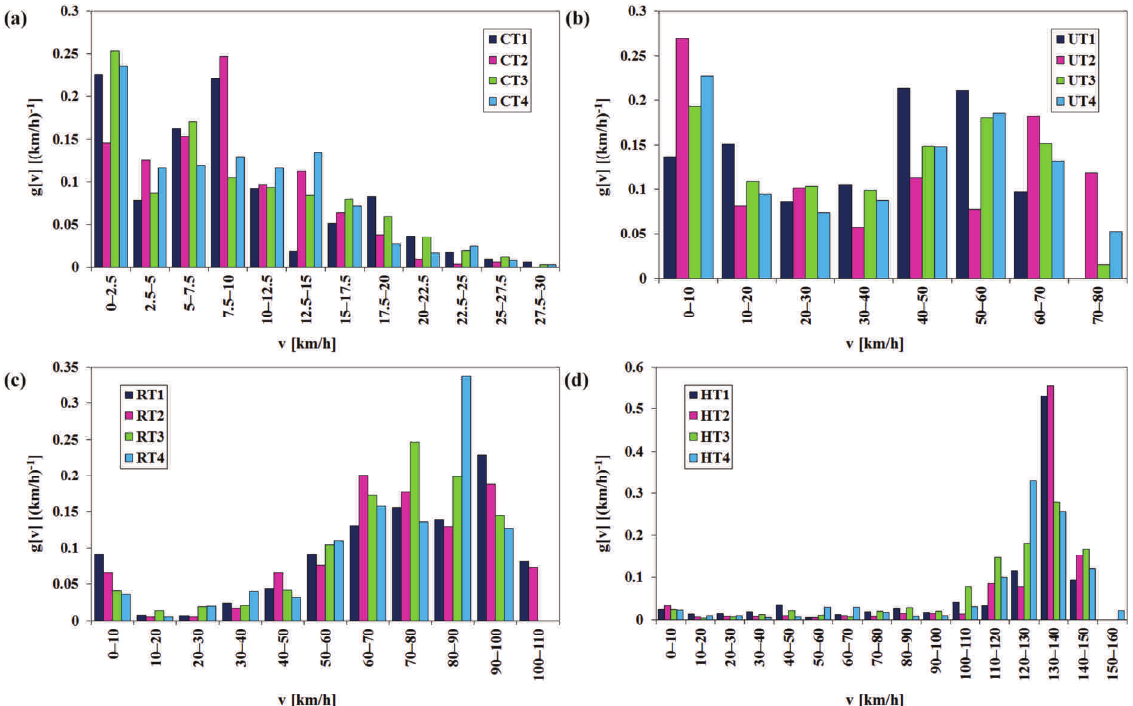
Fig. 7. Comparison between the discrete probability density (g[v]) of vehicle velocity (v) in the vehicle driving test cycles for: a) urban traffic congestions (CT); b) urban traffic (UT); c) extra-urban traffic (RT); d) high-speed traffic